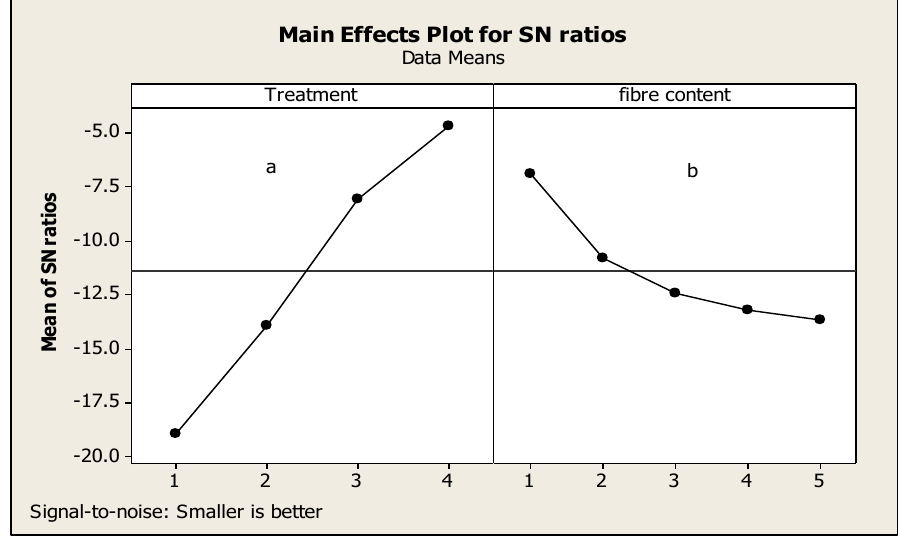
Fig. 6. Main effects for signal-to-noise ratio of treatment and fibre content on percentage of water absorption.